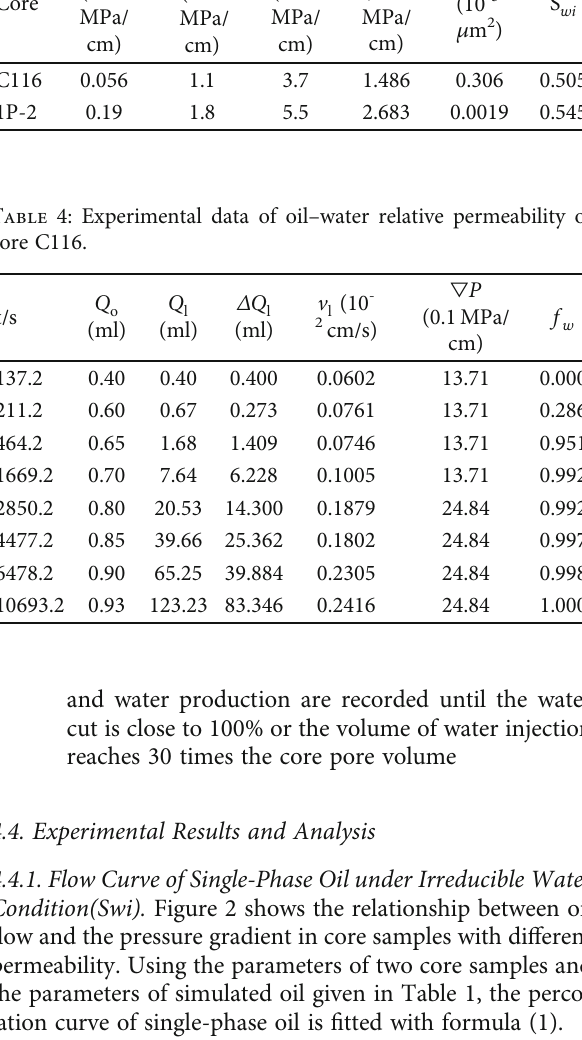
Table 3: Flow parameters of the C116 and 1P-2 core samples. Core